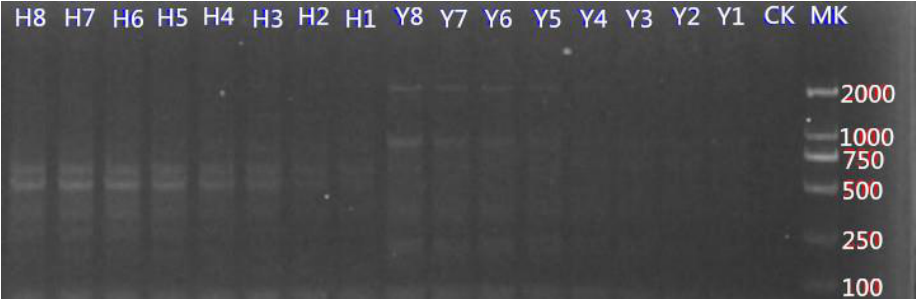
Figure 8. Agarose gel electrophoresis map of the cbbLR1 gene PCR product.